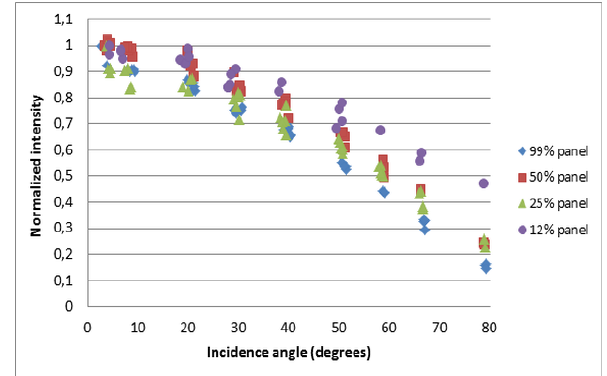
Figure 7. The 4-step Spectralon scanned from 10 m distance. Incident angles range between 0 ⁰ and 80 ⁰ with approximately 5 ⁰ steps. The intensity values are normalized to 1 at 0 ⁰.